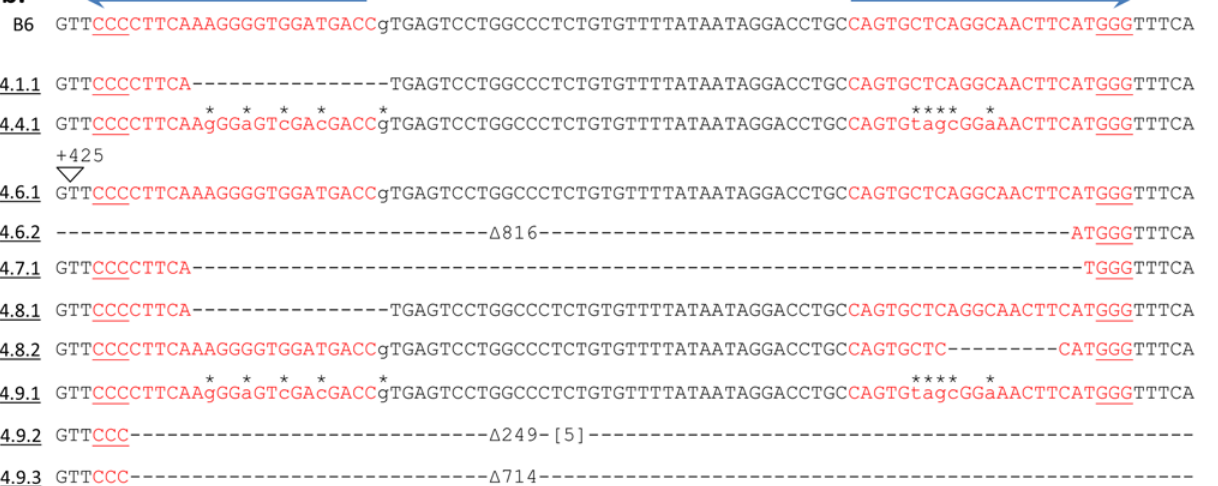
Figure 5. Mosaicism following CRISPR-Cas9-mediated genome-editing. (a) Mouse 4.9 is shown in three photographs (top) along with a WT B6 littermate (bottom) at four weeks of age. The patchy coat color distribution was evident several days after birth and has remained consistent throughout development. (b) The results of combined guide B and D editing in B6 mice with a donor template are depicted. The mutations present in the modified donor are indicated by ( * ) above the lowercase base substitutions. Mice are numbered as in Fig. 2b. The B6 allele is indicated with the positions of guides B and D as in Fig. 1. Sequencing results from unaltered Tyr alleles are not shown (4.1.2, 4.4.2, 4.8.3). No PCR product was detected for allele 4.7.2 suggesting a large indel. Deleted nt (-). Inserted nt in